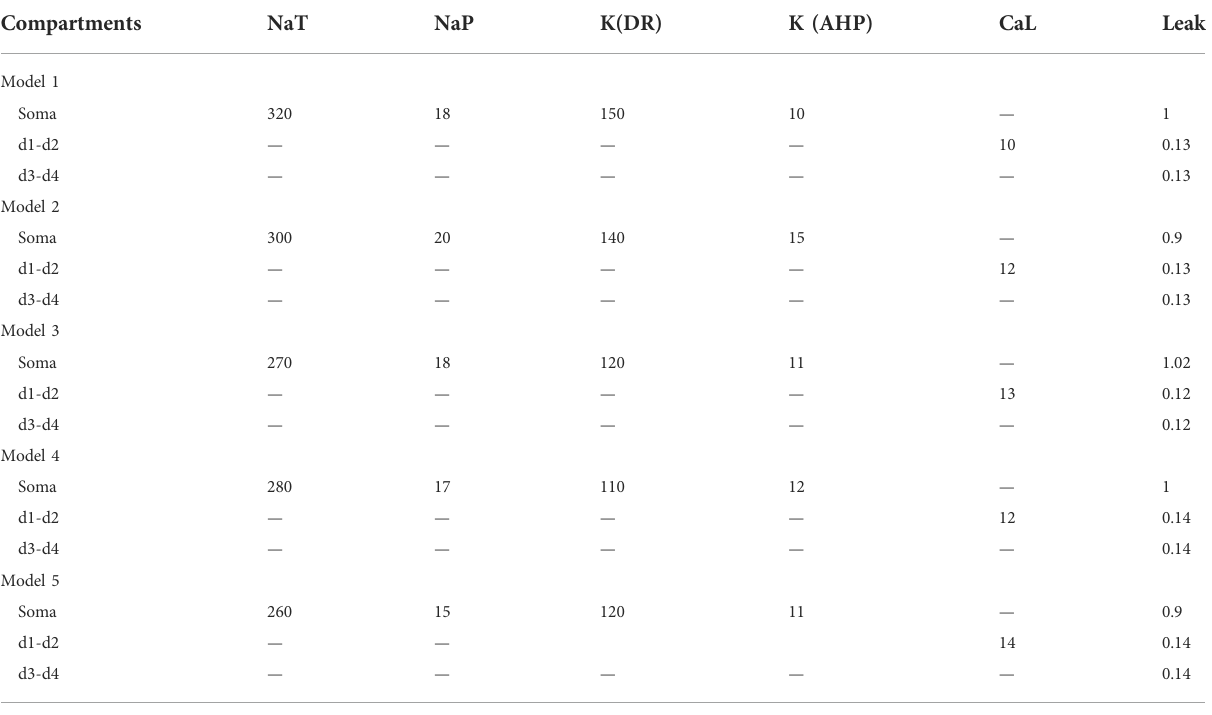
TABLE 3 Distribution and density of ionic conductances (mS/cm 2 ).